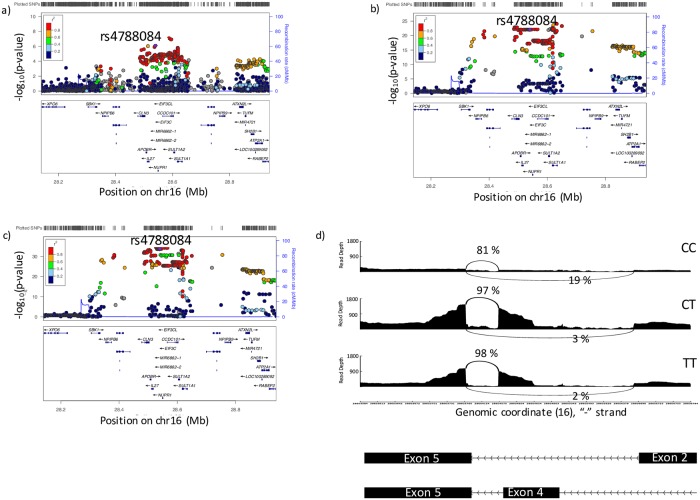
Colocalization analysis of sQTLs and eQTLs with GWAS data at 16p11.2.a) Locus zoom plot of the GWAS association at 16p11.2. b) Locus zoom plot of sQTL data for the association between SULT1A2 splicing with genotype. c) Locus zoom plot of eQTL data for the association between SULT1A2 whole gene expression with genotype. d) Visualization of the SULT1A2 splice site associated with rs4788084 genotype. The y axis shows read depth and the x axis shows genomic position on chromosome 16. Arched lines indicate junction spanning reads.